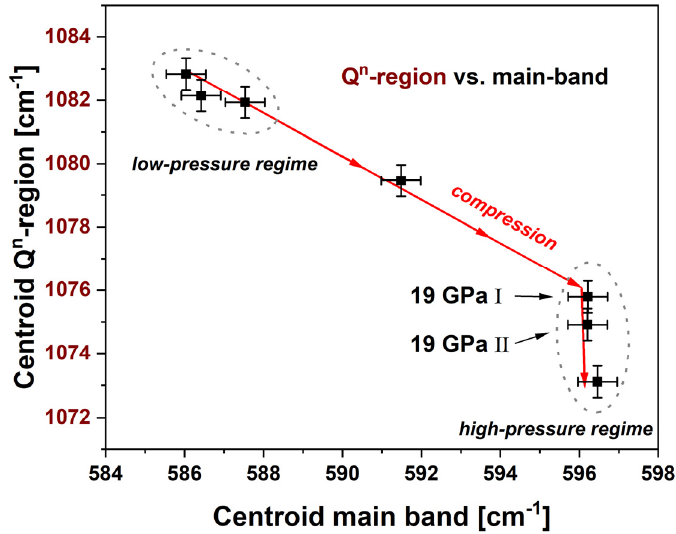
Figure 13. Comparison of the centroid of the Q n -region (left red axis) vs. the main band centroid (bottom black axis); a stronger variation of the main band in the elastic region can be observed; a linear evolution in the plastic deformation region up to 19 GPa is evident as a logical follow up as both observables behave in the same way in this region; above 19 GPa the Q n -region still shows variation while the main band remains the same; when utilizing Raman spectroscopy to analyze the pressure history it is preferable to use the main band calibration in the elastic region from moderate pressure up to its P onset = 11.8 ± 0.3 GPa and the Q n -calibration at very high pressure as its P end = 21.7 ± 1.0 GPa is located higher; in the plastic deformation region between P onset < P max < P end both calibrations are identical, but the main band shows a higher m f = 1.73 ± 0.13 cm − 1 (Q n -region: m f = − 1.29 ± 0.01 cm − 1 ) and therefore is advantageous.